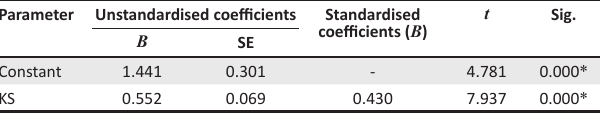
TABLE 8: Parameter estimates for the absorptive capacity on small and medium enterprises’ innovation capabilities model.